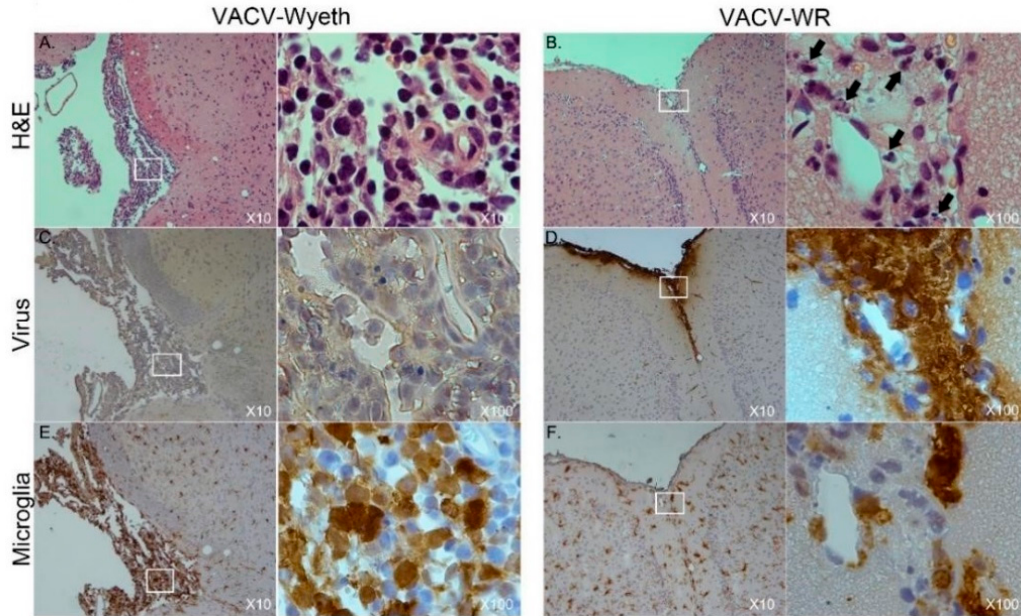
Figure 3. Macrophages/Microglia and virus-infected cells are almost mutually exclusive. Serial sections of meninges, 5 d.p.i with VACV-Wyeth (10 6 pfu infection dose; A,C,E) or VACV-WR (10 2 pfu infection dose; B,D,F). Brain sections were stained with H&E ( A , B ), antibodies to VACV ( C , D ) or antibodies to iba-1 antigen of macrophages / microglia cells ( E , F ); positive stain in brown. White box area enlarged ( × 100) on the right of each × 10 picture. Cell debris are marked with arrows in panel B ( × 100 enlargement).